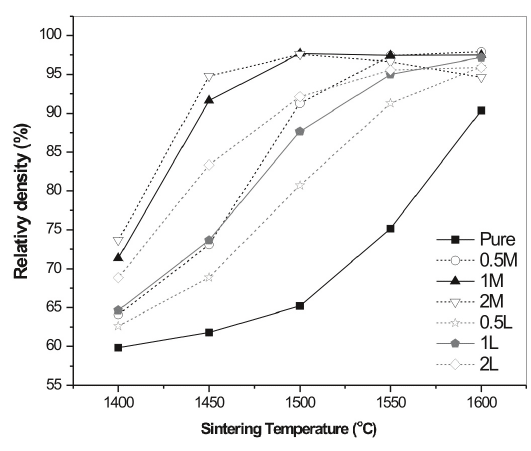
Figure 1. Relative density of conventionally sintered